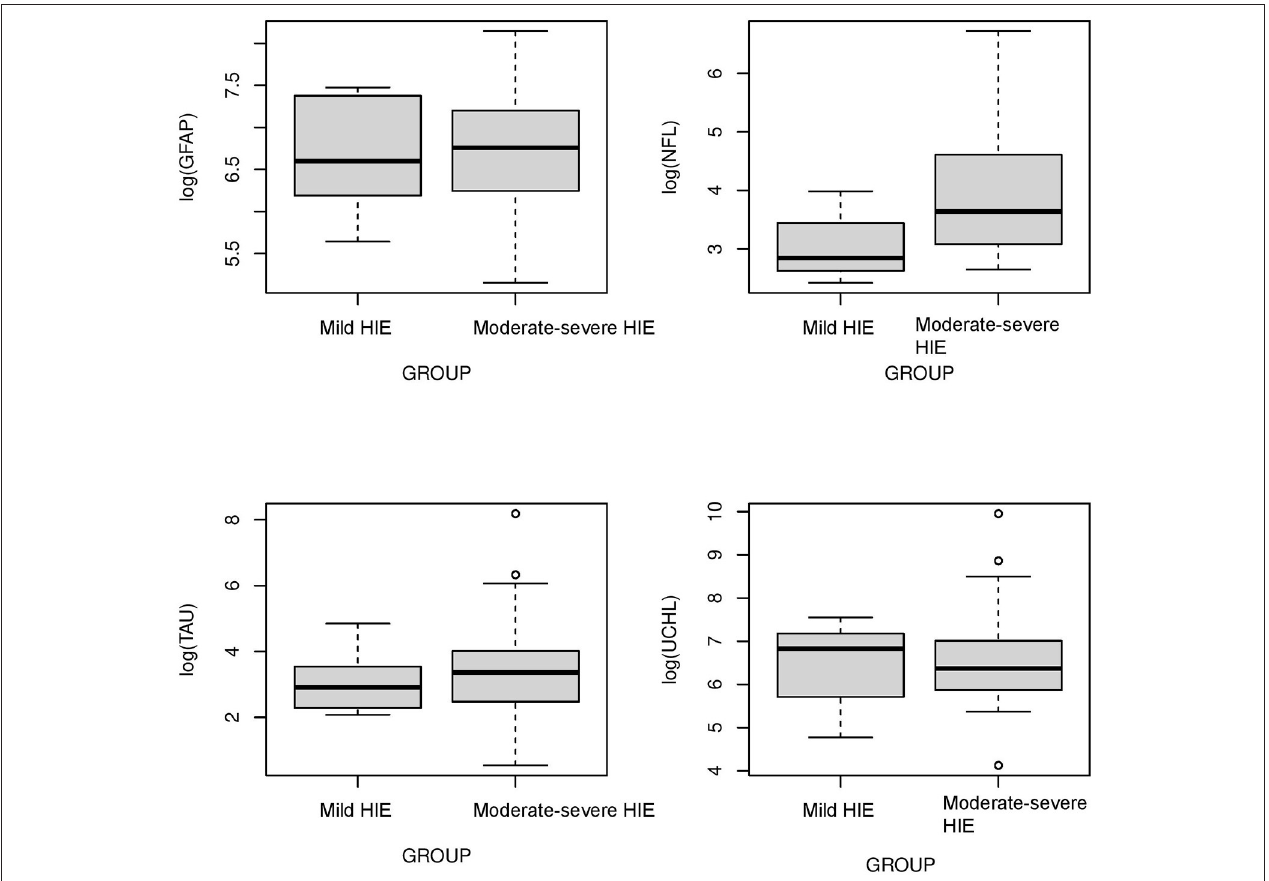
FIGURE 2 | Comparison of neuroprotein biomarkers GFAP , NFL, Tau, and UCHL1 between mild HIE and moderate-severe HIE. Compared to moderate-severe HIE, serum concentration of NFL was lower in mild HIE group ( P < 0.01). Concentration of GFAP, Tau and UCHL-1 was not different between neonates with mild HIE and moderate -severe HIE.